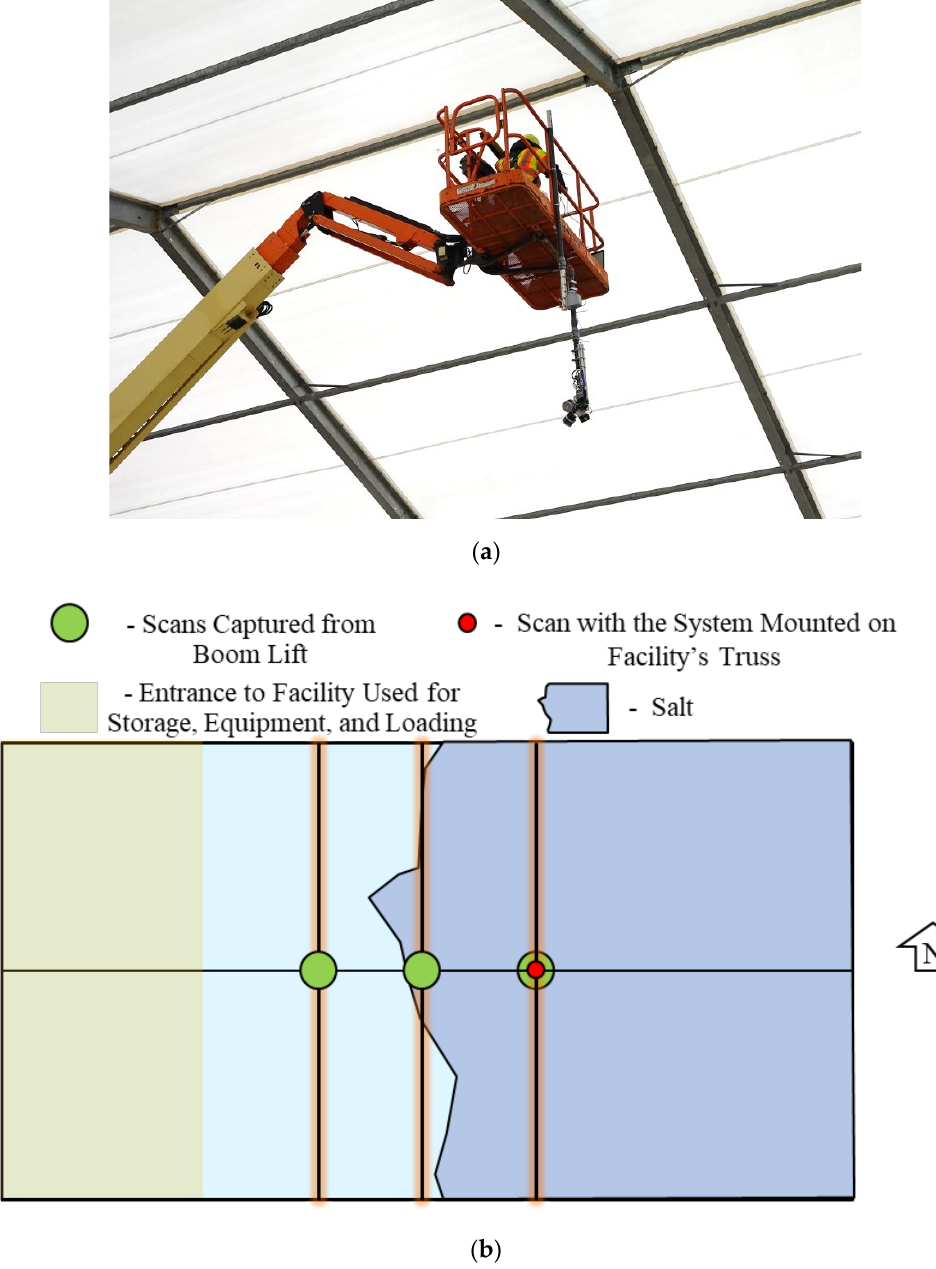
Figure 9. Testing locations for optimal permanent installation ( a ) Installation and Data Collection on Boom Lift ( b ) Location of Scans Relative to Salt Pile.